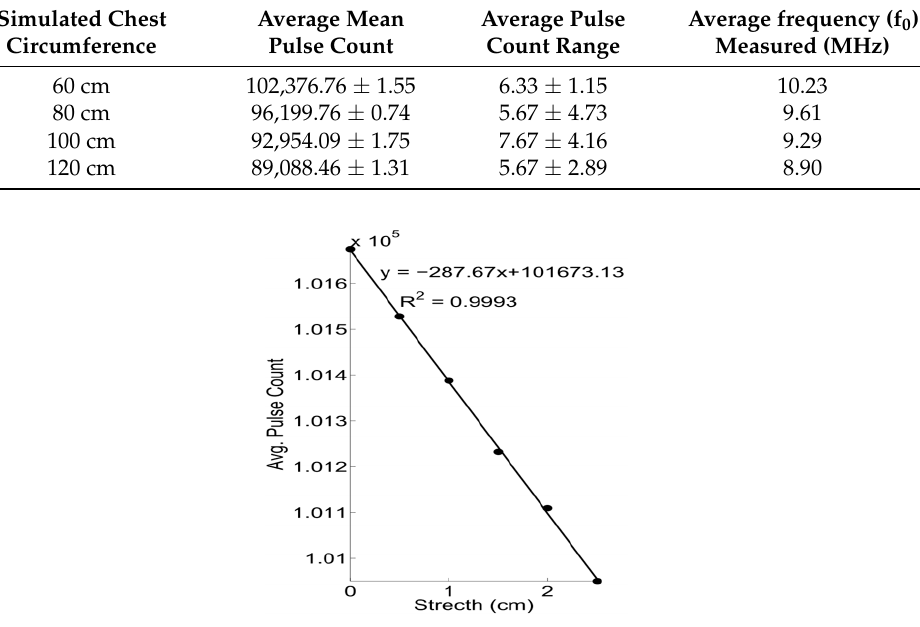
Table 2. Results of chest module noise tests for RIP.